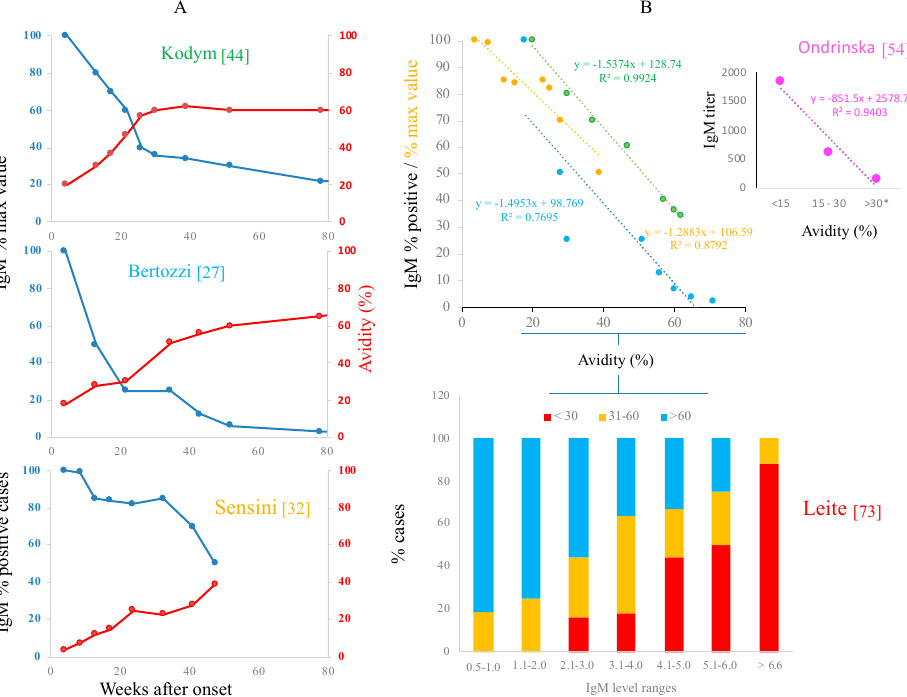
Figure 5. Relationship between IgM and avidity as seen in kinetics ( A ) or direct relation/proportion of cases ( B ). Data from tables or plots of the original works [27,32,44,54,73] were taken and used to build the graphs. Names in different colors are the first authors of these reports. * Considered chronic in that study.